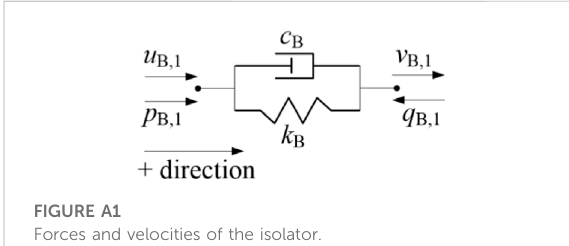
FIGURE A1 Forces and velocities of the